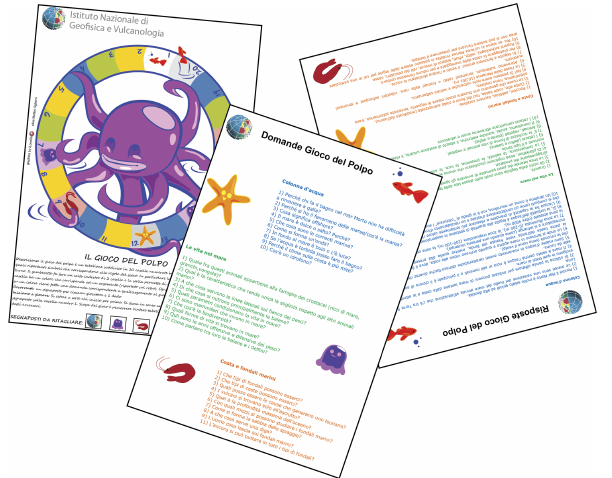
Figure 2. The kit game of the Octopus game. One paper includes the board and the rules of the game. Another paper includes the questions and the corresponding answers about the marine water column, marine life, and seabed and coast (illustrations made by Matteo Sgherri).